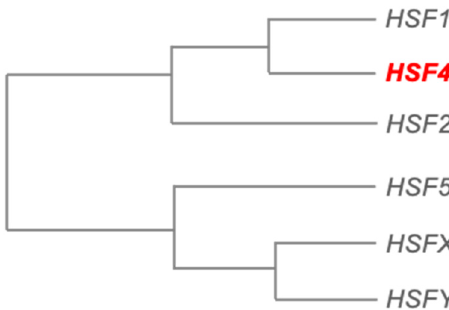
Figure 1. Phylogenetic tree of human heat shock factor (HSF) family members generated using MEGA-X tool (https://www.megasoftware.net, accessed on 15 December 2020). HSF4 is the closest to HSF1 in the phylogeny.